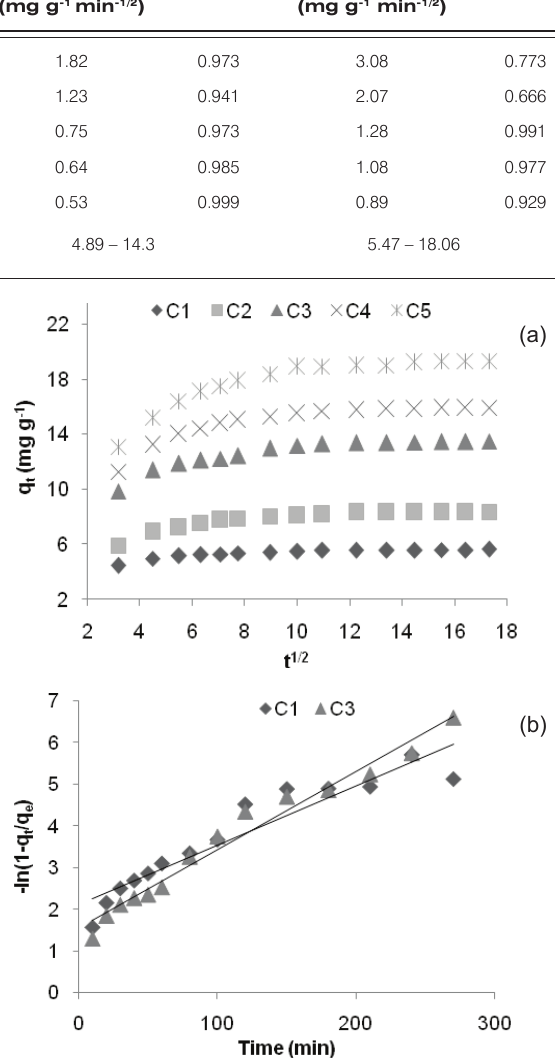
Figure 7. Plots of the intra-particle (a) and film diffusion (b) models for zinc sorption on Amberlite IRA410; C1 = 300 mg L -1 ,